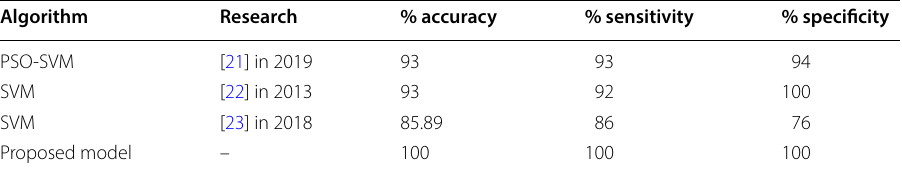
Table 7 Comparison of the results for the proposed method